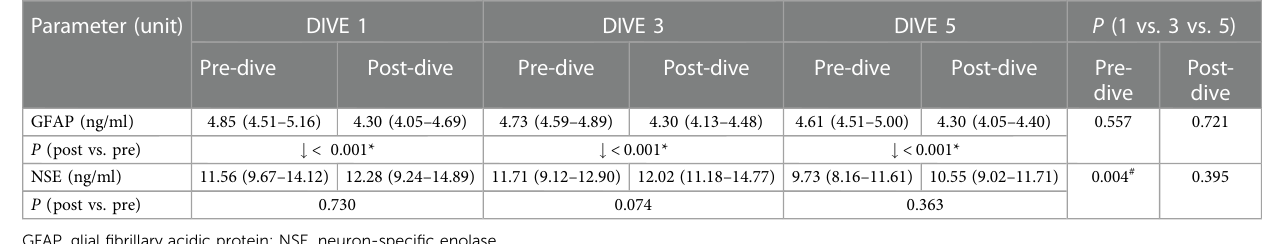
TABLE 3 Results of GFAP and NSE levels before and after the fi rst, third, and fi fth dive. Parameter